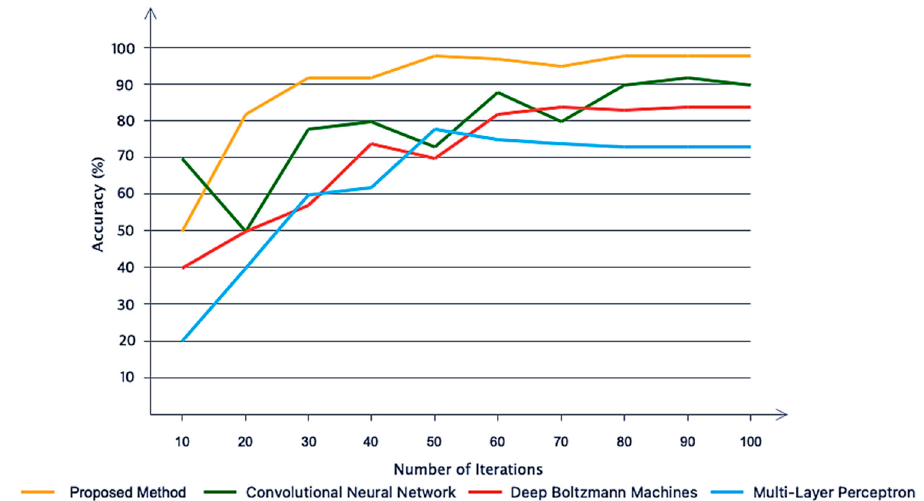
Table 5. Classification accuracy of the suggested method compared with other methods of compar-